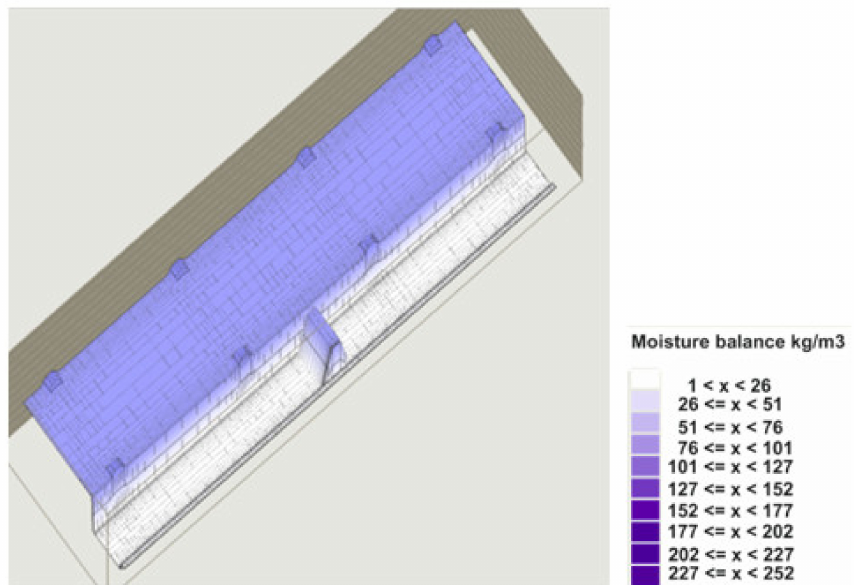
Figure 26. Wall insulated using mineral wool—initiation time (0 h).